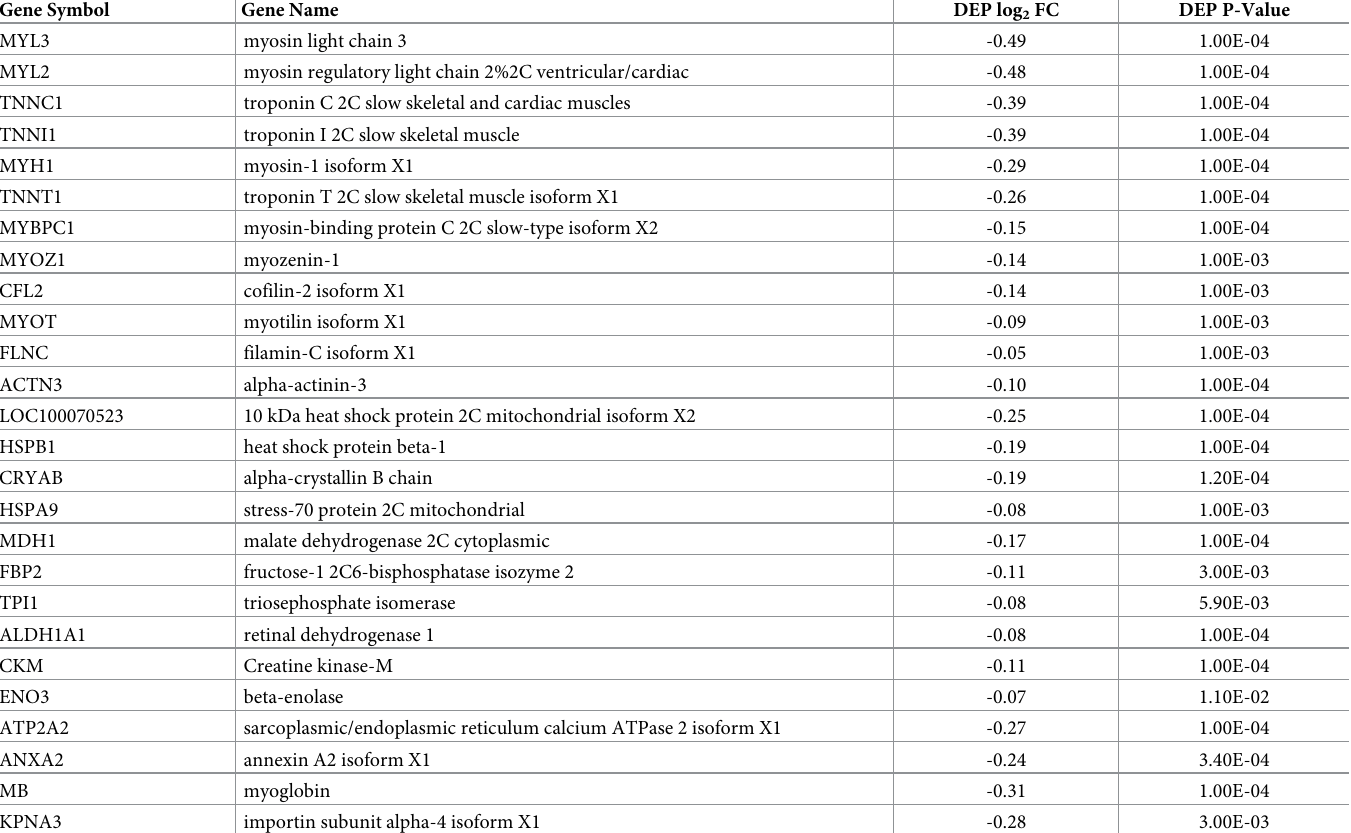
Table 4. Differentially expressed nonmitochondrial proteins (DEP) with decreased expression comparing horses susceptible to recurrent exertional rhabdomyolysis with control.